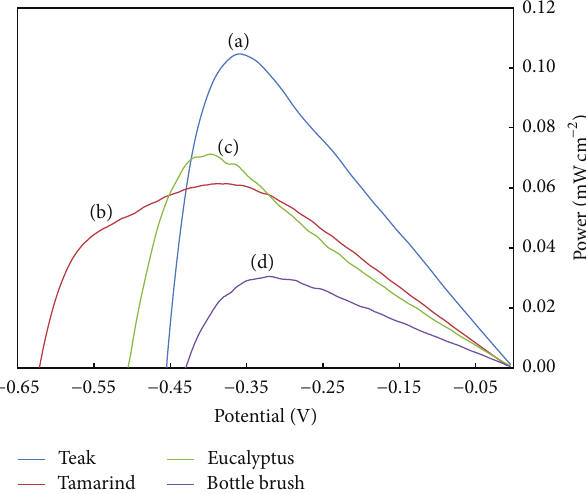
Figure 9: Power versus voltage curves of the DSSCs using the nat- ural dyes extracted from the (a) teak, (b) tamarind, (c) eucalyptus, and (d) bottle Figure 7: Transient current-time ( 𝐽 - t ) profiles obtained under photo visiblelightillumination(intensity256 mW/cm 2 )forthefourDSSCs sensitized by (a) teak, (b) tamarind, (c) eucalyptus, and (d) bottle brush, respectively. Electrolyte composition and intensity are the same as in Figure 6.